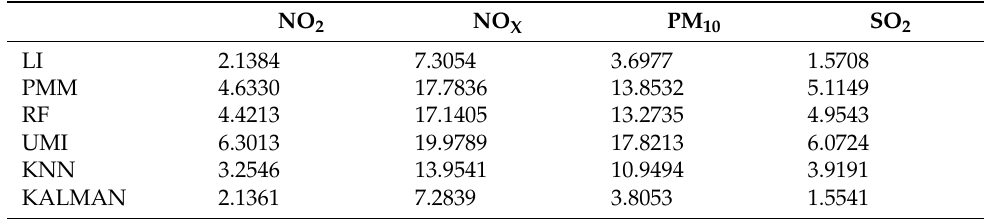
Table 10. RMSE STATION ST